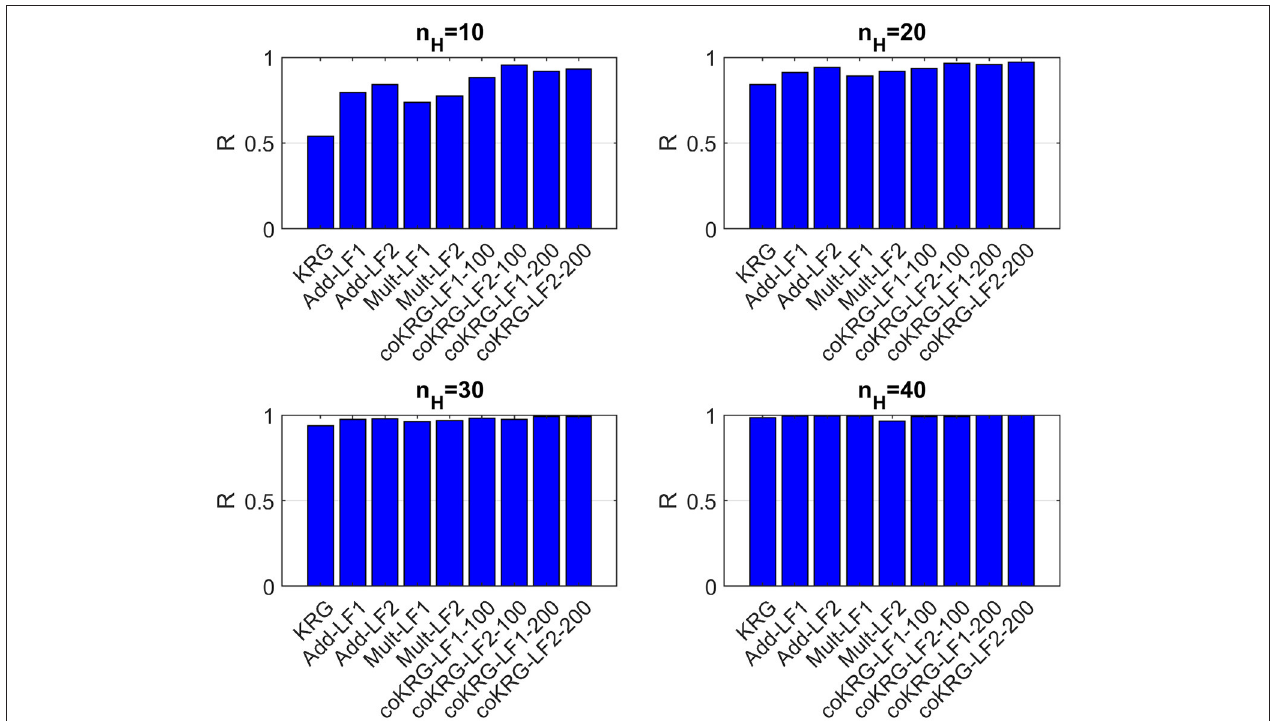
FIGURE 7 | Comparisons of all methods on the average value of the R performance metric for various training sample sizes.